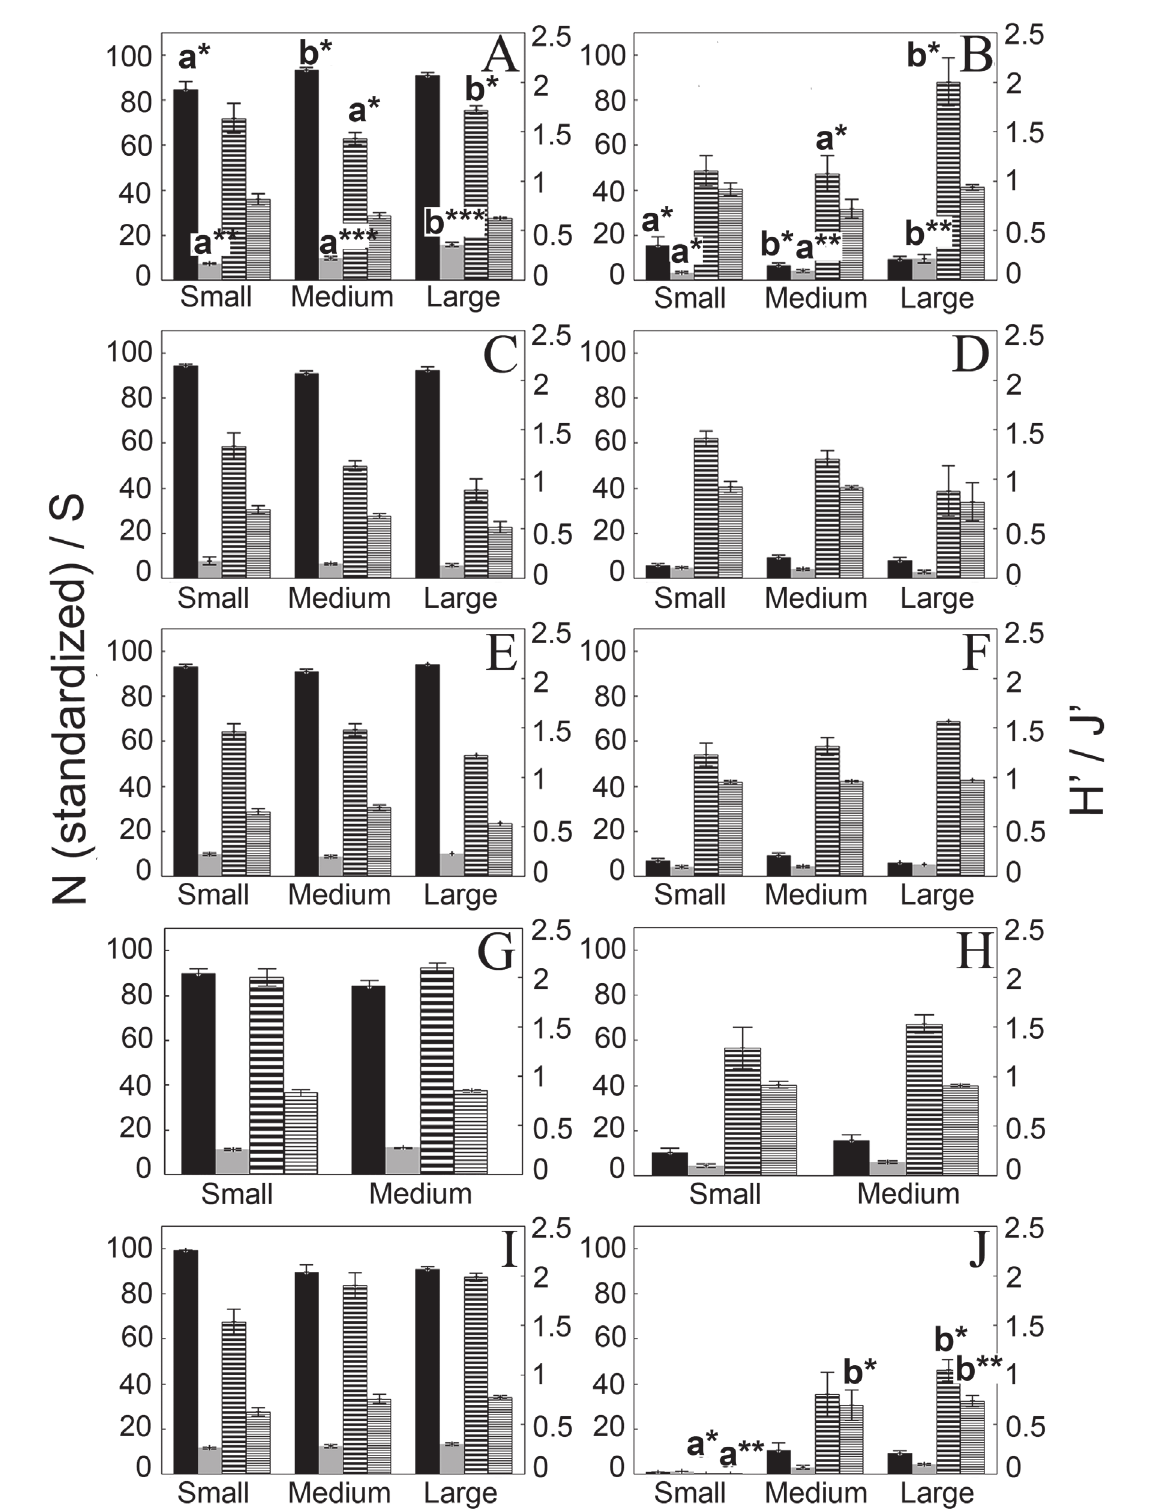
Fig . 3. – Bar diagrams of standardised abundance (black bars), number of species (grey bars), biodiversity (thick-lined bars) and evenness (thin-lined bars) of the sessile (left panes) and motile epifauna (right panes), which was found on the five sampled populations of Pinna nobilis . data have been grouped for each size class of the basibiont (means ± Se): small < 25 cm; medium > 25, < 40 cm; large > 40 cm; tukey’s honest significant differences of means are indicated by letters on the top at a p -level of 0.05 (*) and 0.001 (**). A-B. echaâra, n1. c-d.